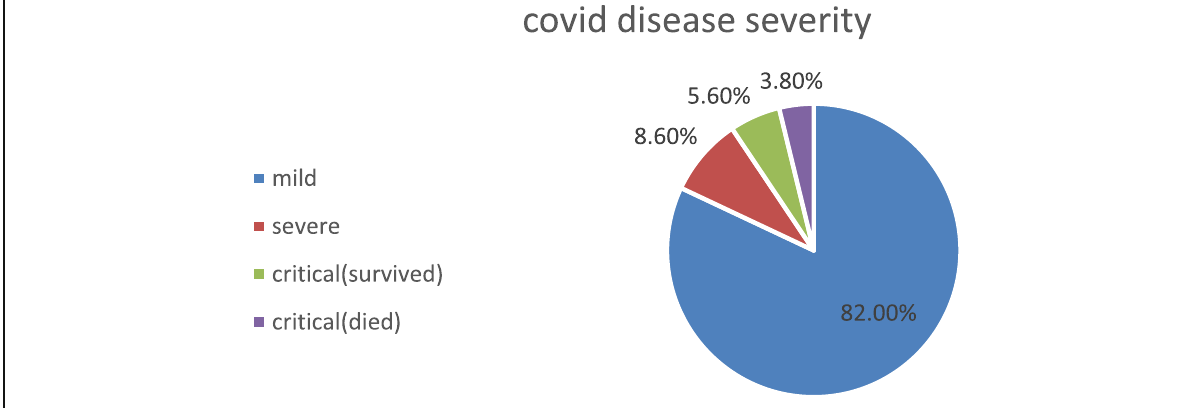
Fig. 1 Disease severity distribution